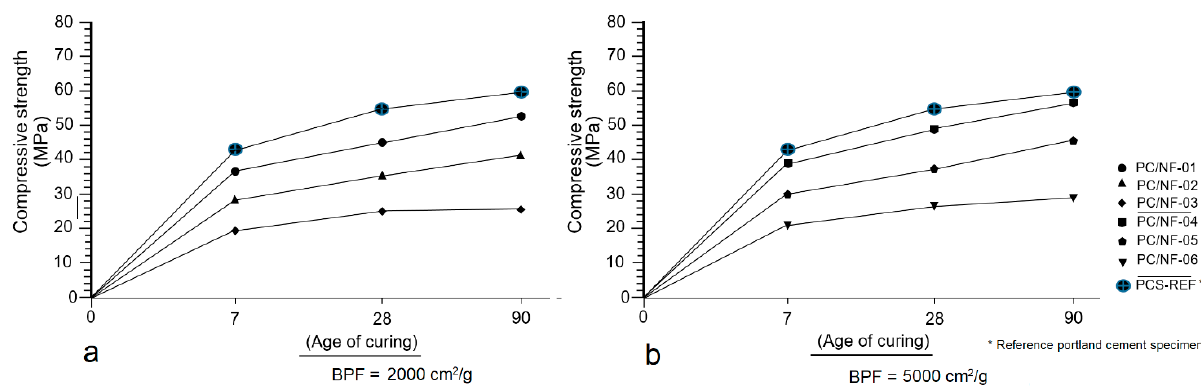
Figure 6. Behaviour of the mechanical strength of specimens elaborated with substitution of PC by NF in 10, 25 and 40%. In ( a ) the specimens have BPF of fluorite of 2000 cm 2 /g, while in ( b ) the BPF is 5000 cm 2 /g.